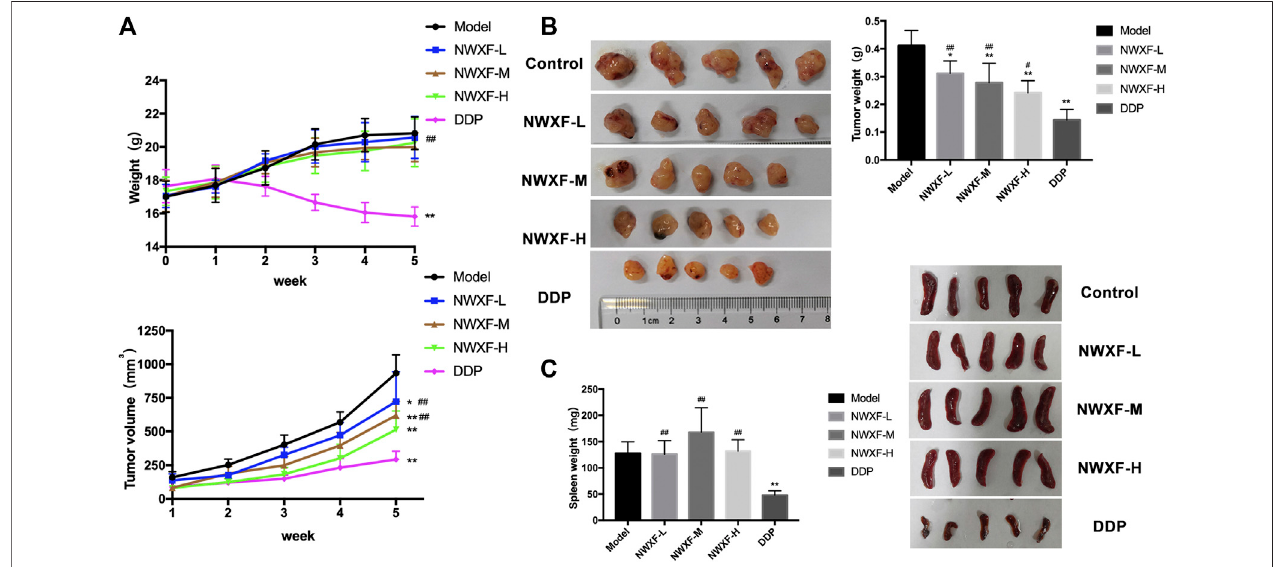
FIGURE 3 | Anti-tumor activity of NWXF in subcutaneous xenografts model. (A) Mean body weights and tumor volume for indicated weeks were presented as mean ± SD ( n (cid:2) 5). (B) The pictures of tumors and the tumor weight. (C) The pictures of spleens and the spleen weight. p p < 0.05, pp p < 0.01 vs. the control group. # p < 0.05, ## p < 0.01 vs. the DDP